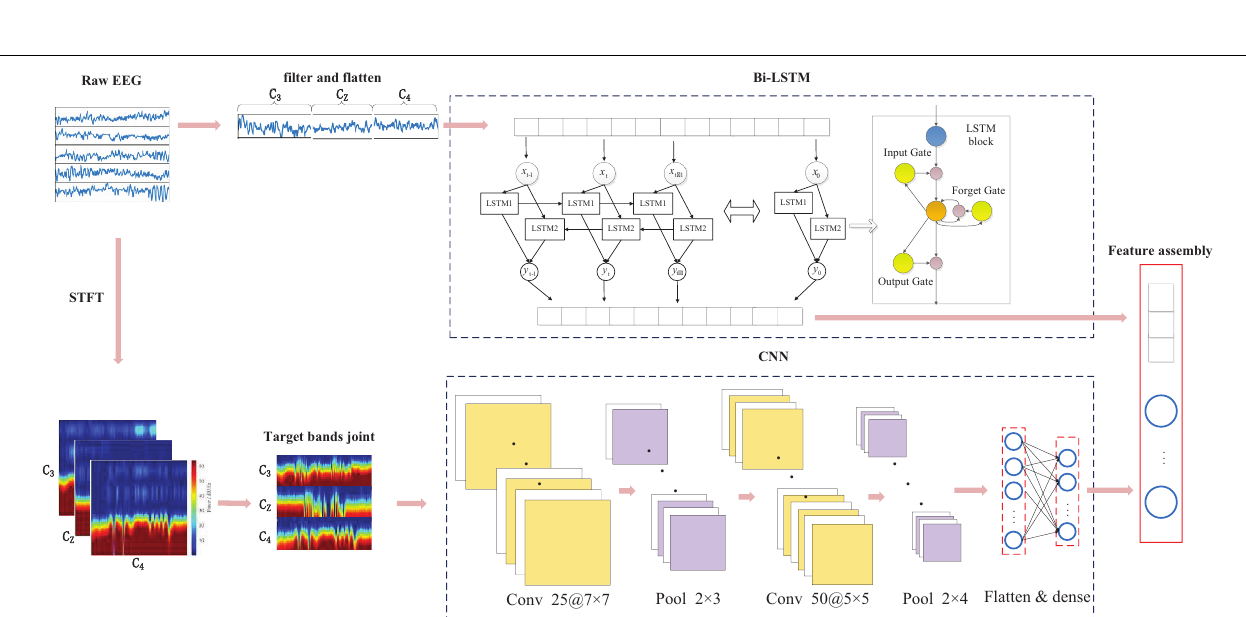
FIGURE 3 | Parallel BLSTM and convolutional features fusion architecture. Bidirectional LSTM (Bi-LSTM) and convolutional neural network (CNN) were employed to learn the different hierarchical representation from raw data, then reconstruct the fusion features through stacked sparse autoencoder (SSAE).